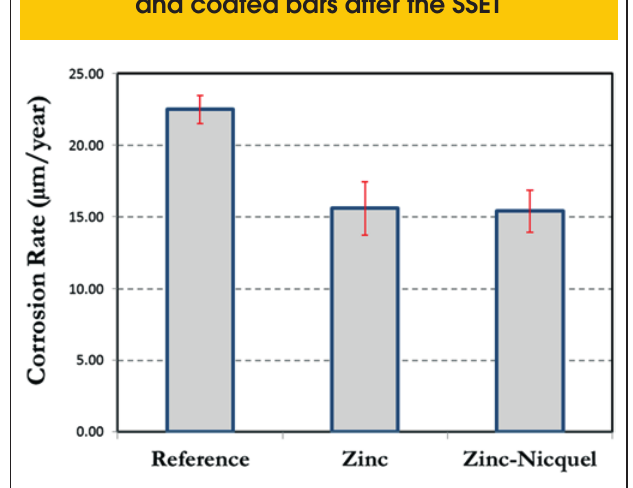
Figure 9 – Corrosion rates for the conventional and coated bars after the